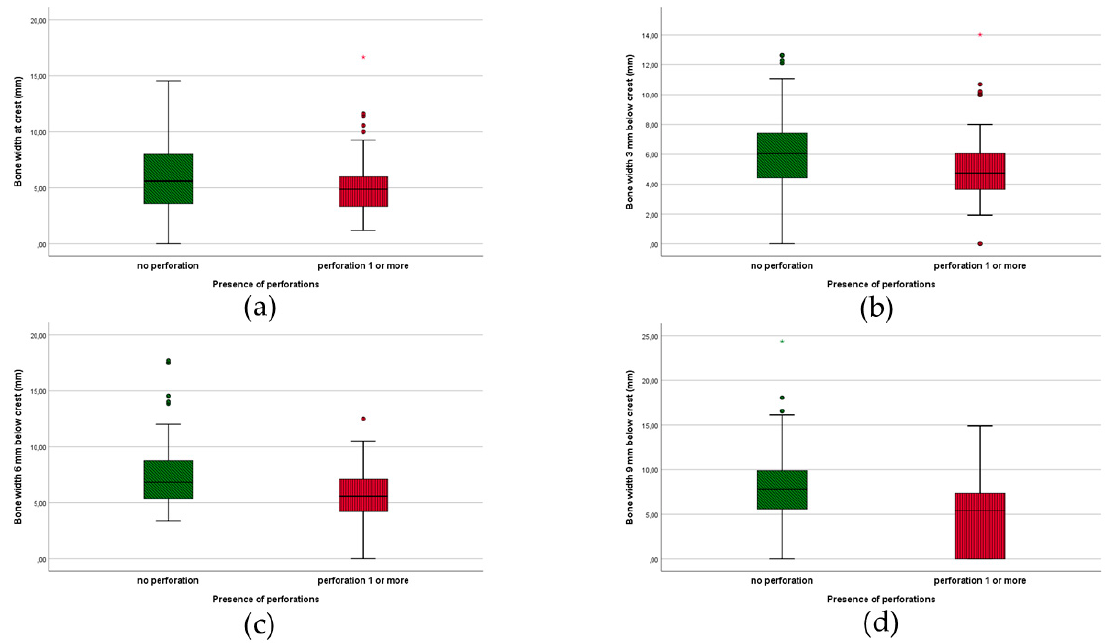
Figure 8. Presence of perforations in relation to bone width at different MDI levels ( a ) crestal; ( b ) 3 mm; ( c ) 6 mm; ( d ) 9 mm.